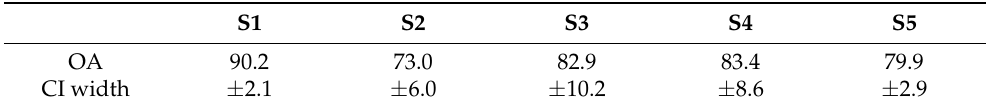
Table 4. Overall accuracy (OA) in percentage attained in the subzones, and width of the confidence interval (CI) at the 95% confidence level. Acronyms of strata as defined in Figure 3. S1 S2 S3 S4 S5 OA 90.2 73.0 82.9 83.4 79.9 CI width ± 2.1 ± 6.0 ± 10.2 ± 8.6 ±